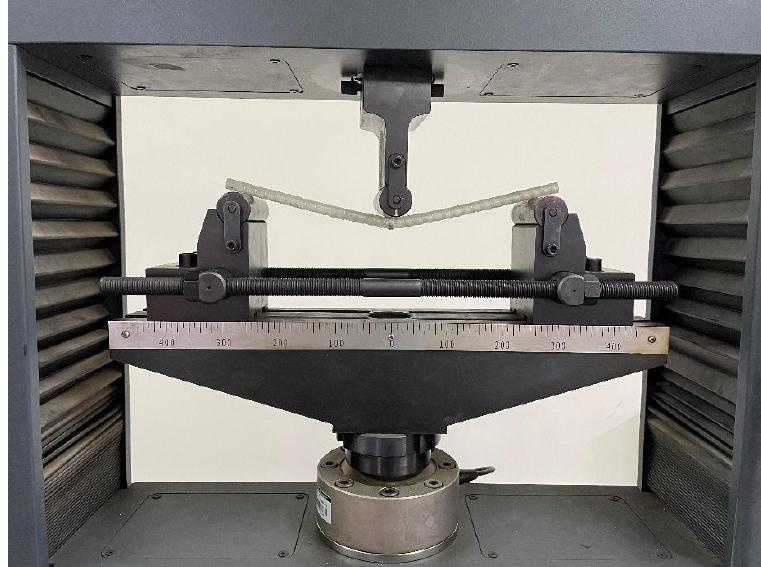
Figure 2. The 3-point bending test fixture .